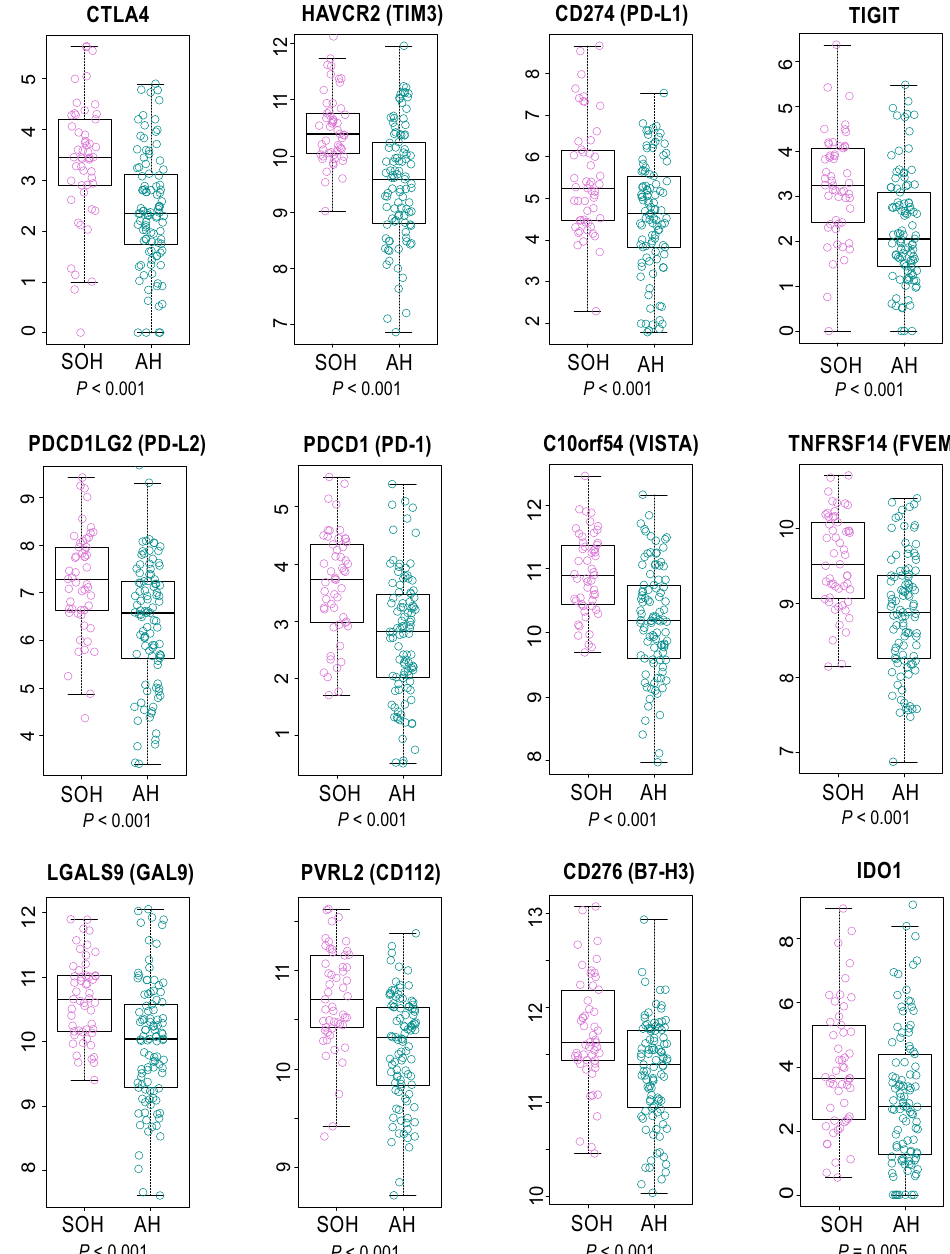
Figure 5. Gene expression levels of inhibitory checkpoint molecules in the silence of Hippo (SOH) and active Hippo (AH) subgroups in The Cancer Genome Atlas. Most inhibitory checkpoints were markedly upregulated in the SOH